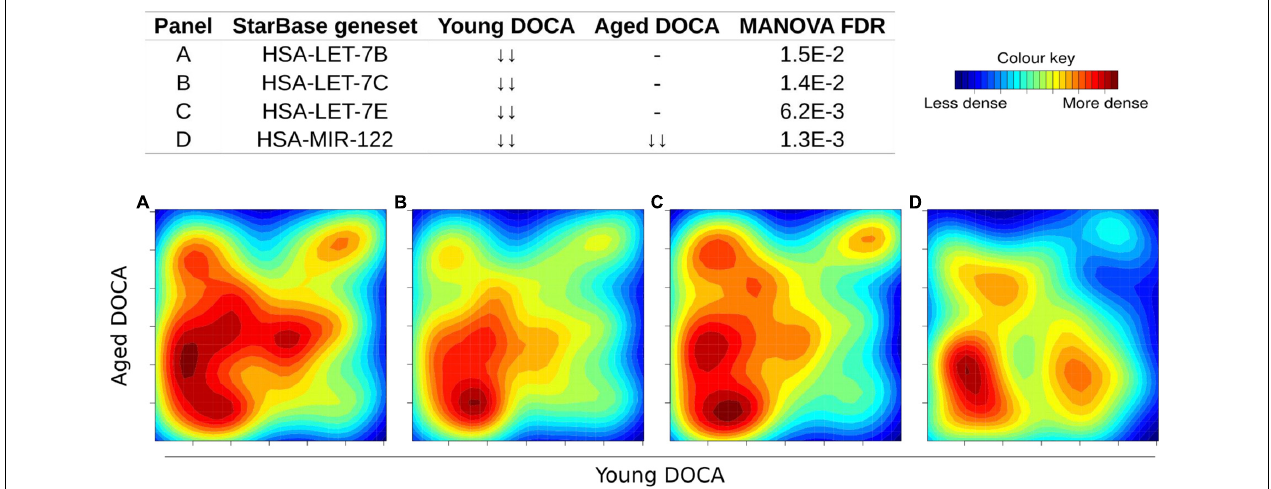
FIGURE 10 | Two-dimensional pathway analysis of microRNAs whose targets were down-regulated in both young and aging DOCA mice (full list at Supplementary Table S10). Showing some examples including (A) let-7B, (B) let-7c, (C) let-7e, and (D)